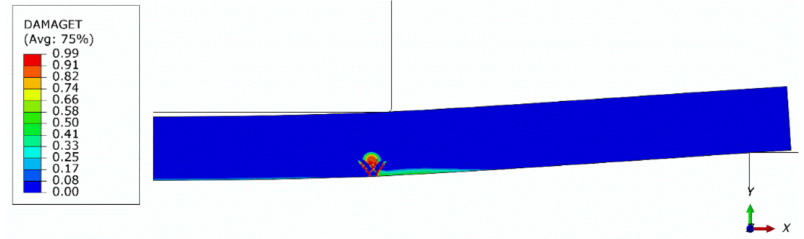
Figure 14. Contour plot of the tension damage parameter ( d t ) after failure (axisymmetric model, global mesh size: 0.5 mm); deformed configuration; displacements scaled 10